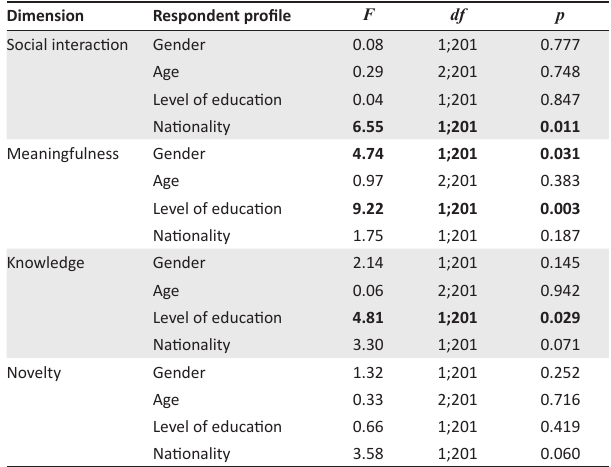
TABLE 6: Differences in perceptions of cognitive dimensions based on demographics: Marine protected